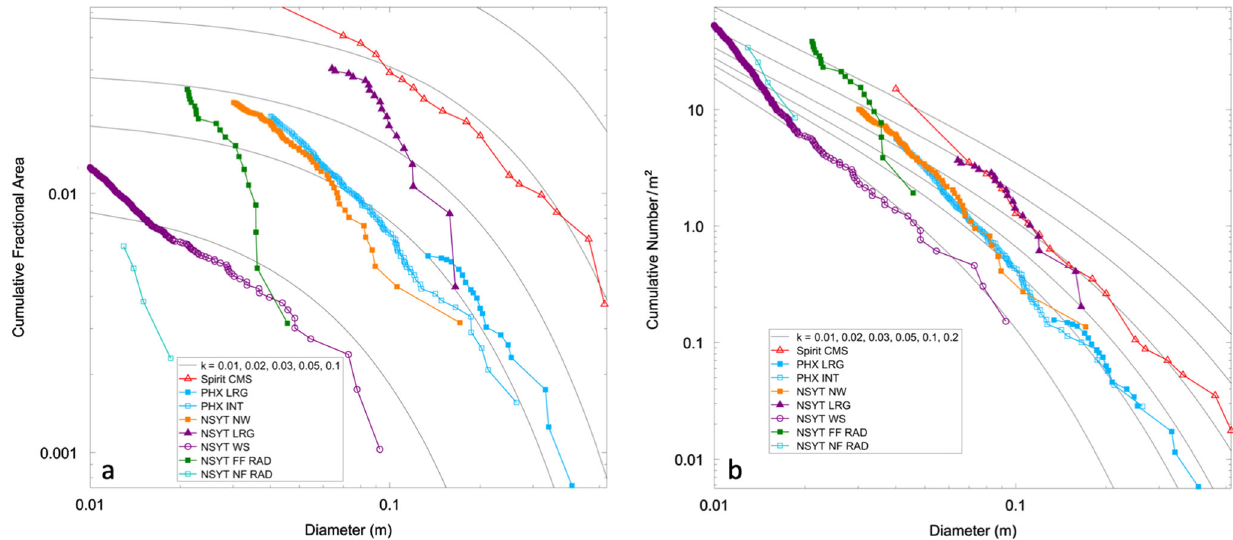
Fig. 10 Rock size-frequency distributions. a Cumulative fractional area and b cumulative number per m 2 versus diameter of rocks near the InSight lander as well as those measured at the Spirit (Spirit CMS for Columbia Memorial Station) and Phoenix (PHX) landing sites. Also shown are exponential model size-frequency distributions for rock abundances (k) of 1%, 2%, 3%, 5% and 10% 30 . Note curves in b are not exponentials and approach a straight line at small diameter (note that fractional area is dependent on the diameter squared, whereas cumulative number is not), but are matches to the exponential models based on cumulative fractional area in (a). Surface rock counts are: near and far RAD spots (NSYT NFF RAD and NSYT FF RAD, respectively), the workspace (NSYT WS), the area to the northwest (NSYT NW), and the area to the south with the largest rocks (NSYT LRG). Spirit CMS from Golombek et al. 33 , Phoenix intermediate area (PHX INT) from Heet et al. 68 and Phoenix largest rocks (PHX LRG) from Golombek et al. 32 . Measurement uncertainty as stated earlier is between 1 – 4 mm, which would have no appreciable effect on the horizontal length and width of rocks. For oblique images, further processing is necessary to calculate the two oblique axes in meters. To convert oblique measurements from pixels to meters, two axes may be calculated as the product of the distance from the camera (in meters), the camera ’ s angular resolution of 0.8 milliradians/pixel, and the number of pixels for each axis calculated from convex hulls. Distance is calculated as the square root of the sum of the squares of the differences in (x,y,z) coordinates between each rock ’ s center as extracted from a stereo correlation map and the location of the camera derived from IDA telemetry and lander orientation. Minimum and maximum axes are averaged to yield the mean diameter for each rock. The cumulative fractional area (CFA) and cumulative number of the rocks are integrated over the count area as functions of diameter. As an additional exercise, we also used MATLAB to extract all (x,y,z) points within the digitized polygon for each rock where there is suf fi cient stereo coverage and calculated a minimum bounding ellipsoid to those 3D points to yield 3 orthogonal axes (approximate length, width, and height) for each rock. Maximum and minimum axes calculated via this method bound but are typically similar to the maximum and minimum axes calculated using the 2D hulls, except for a small subset of high aspect ratio rocks with long axes pointed away from the camera. The size-frequency distributions measured from landers and in HiRISE images (~0.3cm/pixel) from orbit have been successfully fi t to exponential rock size- frequency models that have been used to describe rock populations for landing spacecraft 2,30 – 32,59 . These models were derived from cumulative fractional area versus diameter plots that are curved on a log-log plot with exponentially fewer rocks with increasing diameter (Fig. 10a) and are generally similar to Rosin